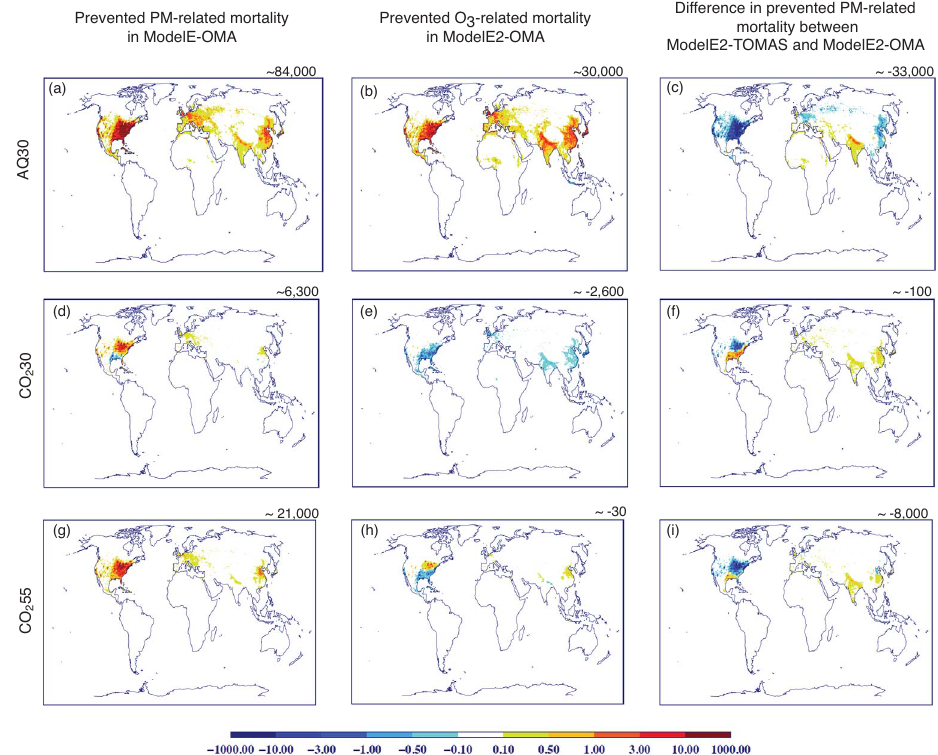
Figure 7. Global distributions of prevented PM- and O 3 -related mortality due to impact of (a, b) the air quality regulations in 2030 (AQ30), (d, e) CO 2 reduction policy in 2030 (CO 2 30), and (g, h) CO 2 reduction policy in 2055 (CO 2 55). The differences between two aerosol models are shown in panel (c) for AQ30, (f) for CO 2 30, and (i) for CO 2 55. In each panel, globally summed mortality is presented in the right upper corner.